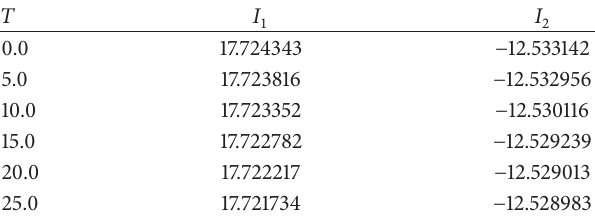
Table 6: Birth of solitons with 𝑎 = 0.5 and 𝑏 = −3.0